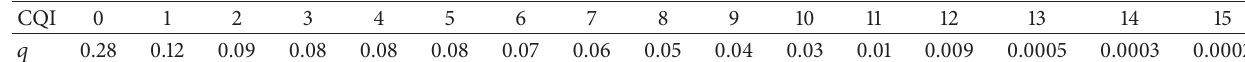
Table 3: Channel state probabilities in Scenario 5.